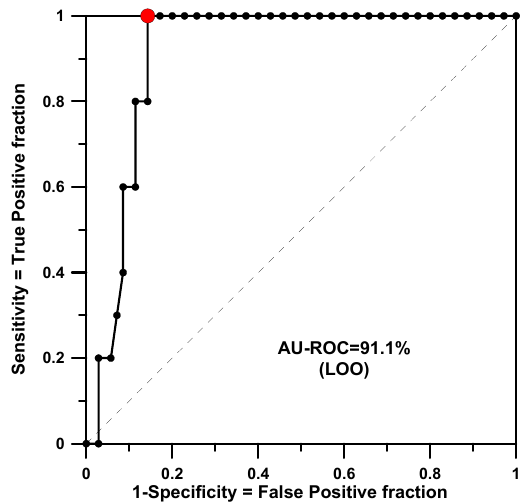
Figure 4. AU-ROC plot for the merged model obtained with a LOO calculation. The classification and ranking parameters for the optimum point marked in Figure 4 are shown in Table 2.